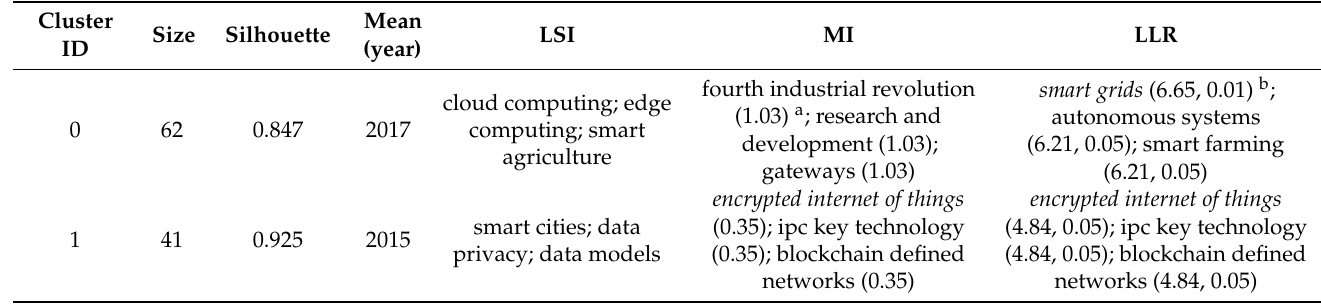
Table A3. Summary of the largest documents’ co-citation clusters in the subject